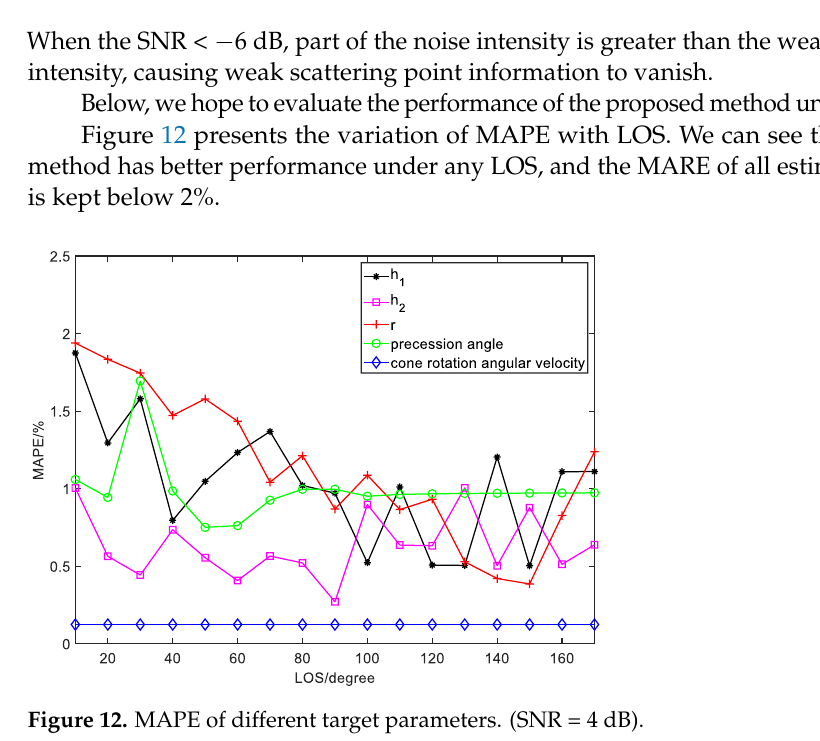
Figure 11. MARE of different target parameters. (LOS = 30 ∘ ).